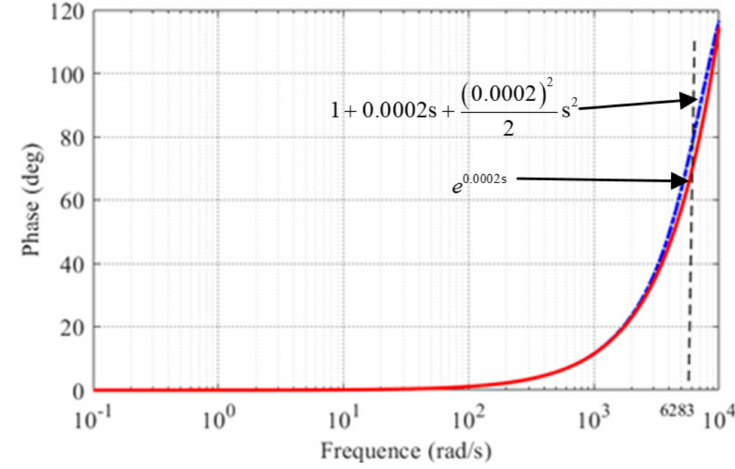
Figure 14. Phase–frequency characteristics of e 0.0002s and 1 + 0.0002s + 1